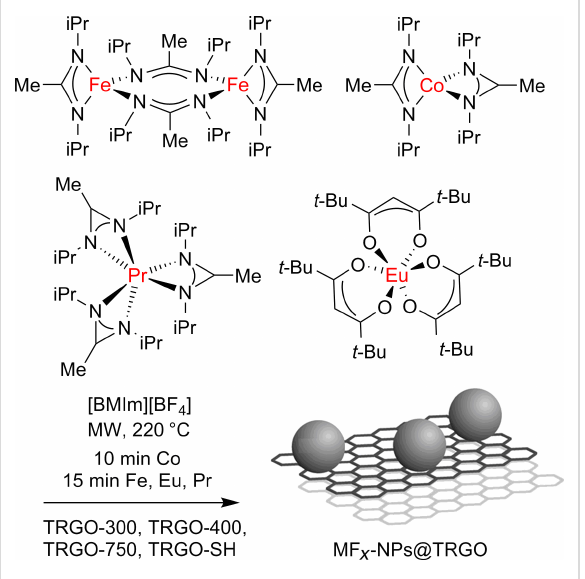
Scheme 1: Synthesis scheme of MF x @TRGO from [M(AMD) n ] and [Eu(dpm) 3 ] by microwave (MW)-assisted thermal decomposition on